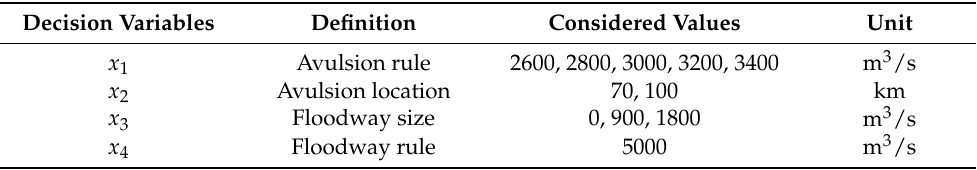
Table 1. Summary of decision variables and their discrete